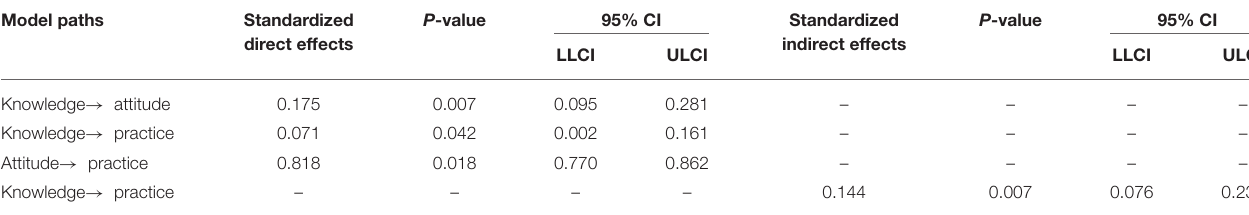
TABLE 6 | Bootstrap analysis of mediating effect significance test for the final